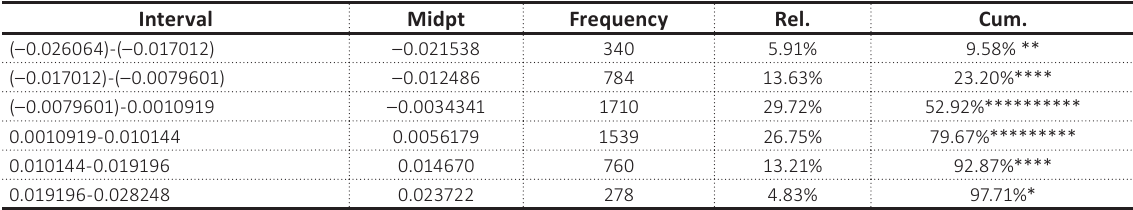
Table 1. Frequency distribution for NIKKEI 225 index